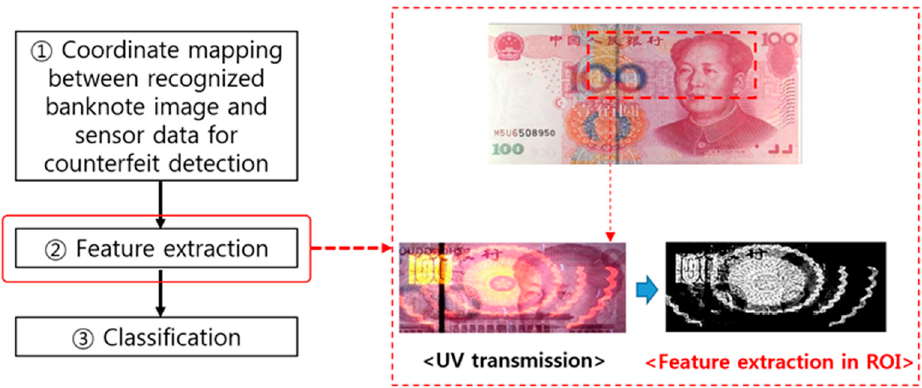
Figure 15. Example of UV anti-counterfeiting feature extraction within an ROI in the counterfeit banknote detection process flow.